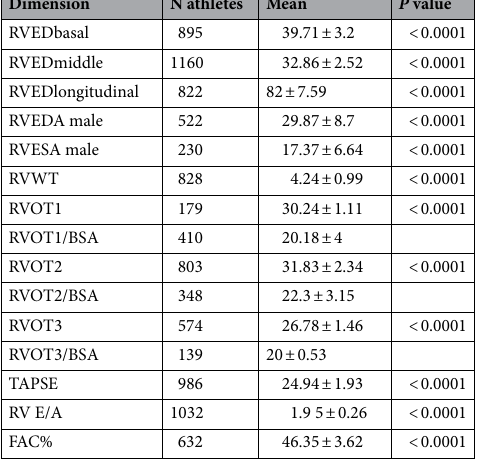
Table 6. T test between ECHO means of athletes and reference means.